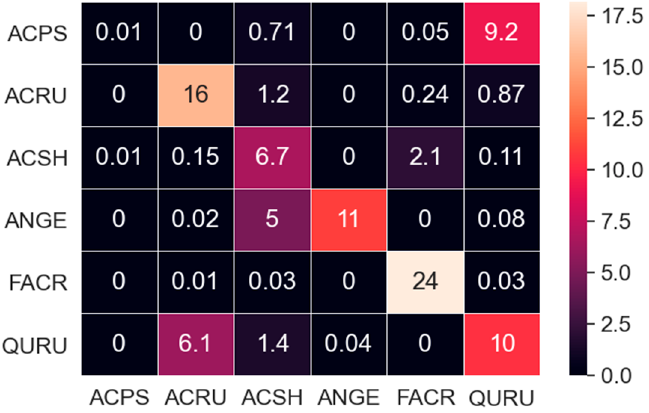
Figure 9. Identification results of CNN2C for prediction of data without LO QURU data.